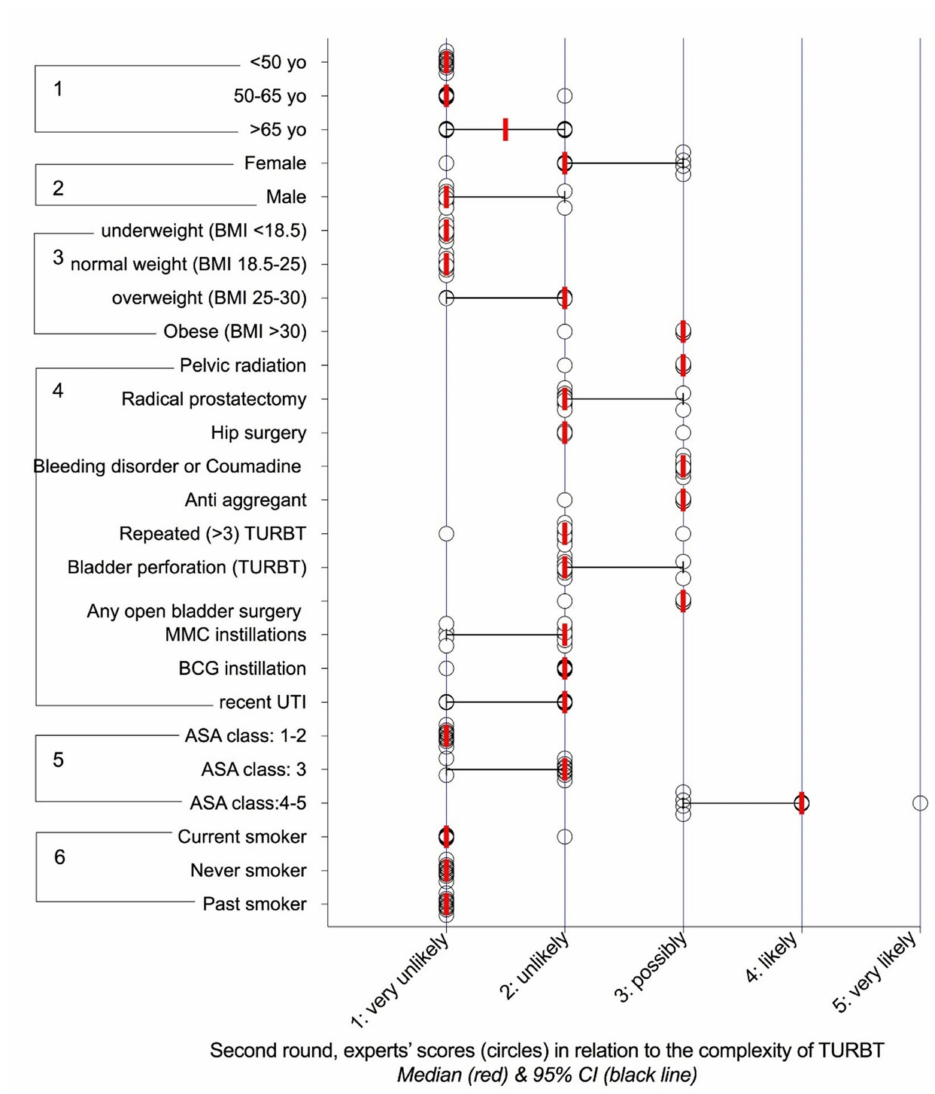
Figure 1. Distribution of the scores regarding the likelihood of incomplete resection and / or prolonged surgery ( > 1 h) and / or significant (Clavien-Dindo ≥ 3) perioperative complications according to patient’s characteristics. ((1) age, (2) sex, (3) weight and body mass index (BMI), (4) patient’s history, (5) American Society of Anaesthesiologists’ (ASA) physical status classification, (6) tobacco smoking. MMC: Mitomycin C, Bacille Calmette Gu é rin (BCG), TURBT: transurethral resection of bladder